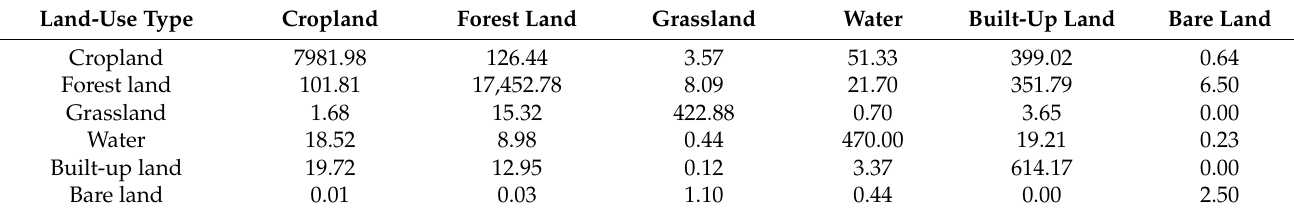
Table 4. Transfer matrix of land-use changes in the CZT urban agglomeration from 2000 to 2015 (unit: km 2 ). Land-Use Type Cropland Forest Land Grassland Water Built-Up Land Bare Land Cropland 7981.98 Forest land 101.81 Grassland 1.68 Water 18.52 Built-up land 19.72 Bare land